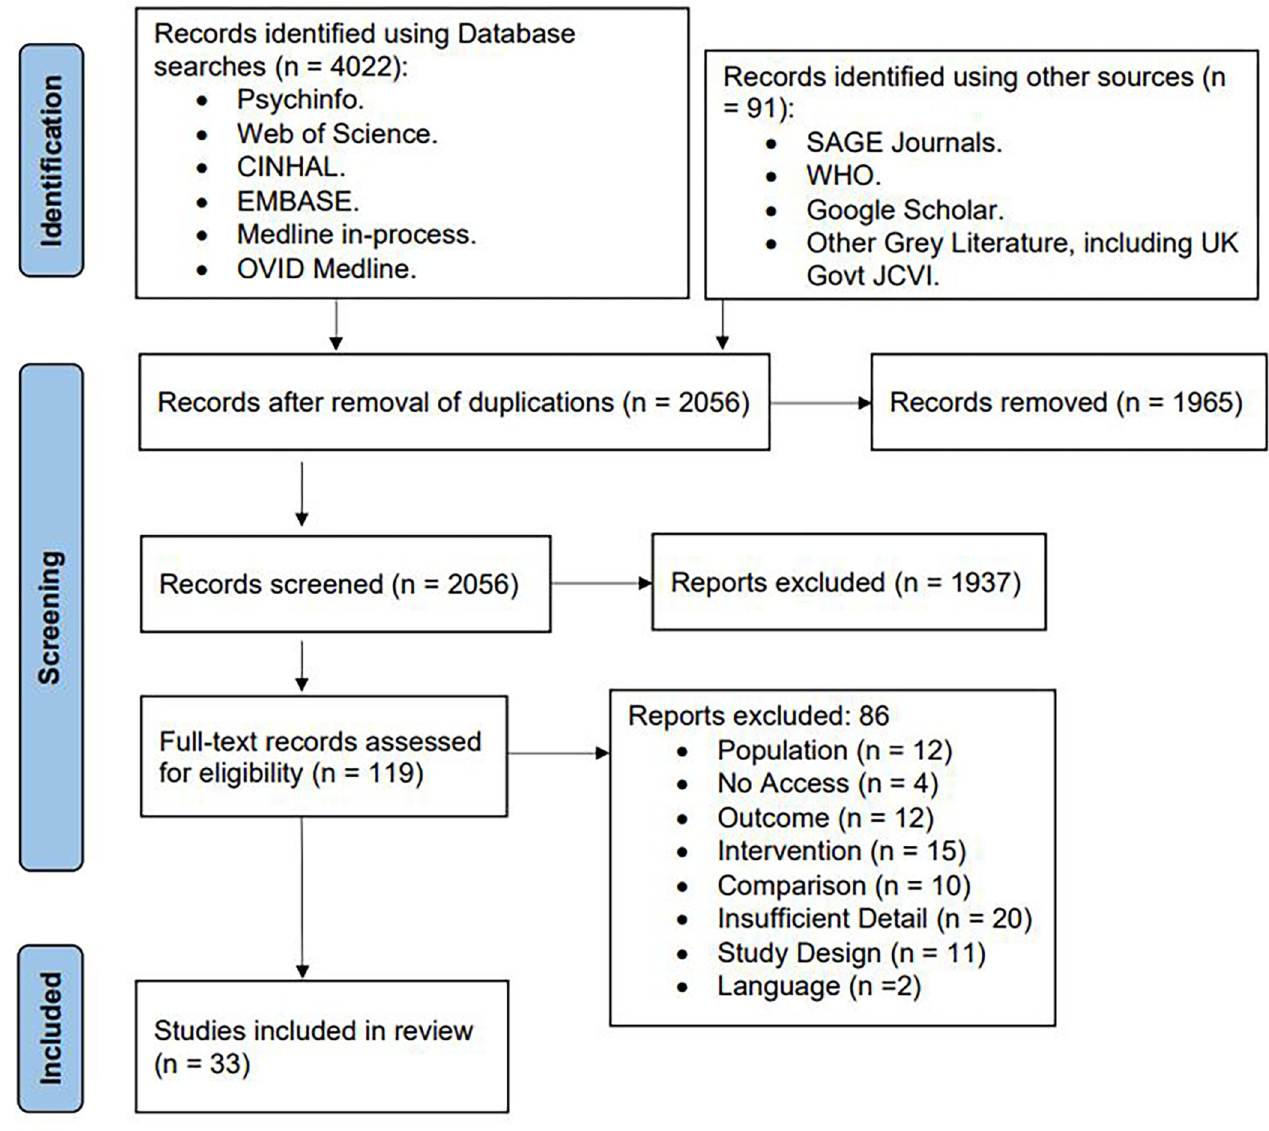
Fig 1. Preferred Reporting Items for Systematic Reviews and Meta-Analyses (PRISMA) flow diagram. This PRISMA flow diagram presents the study selection process [10].